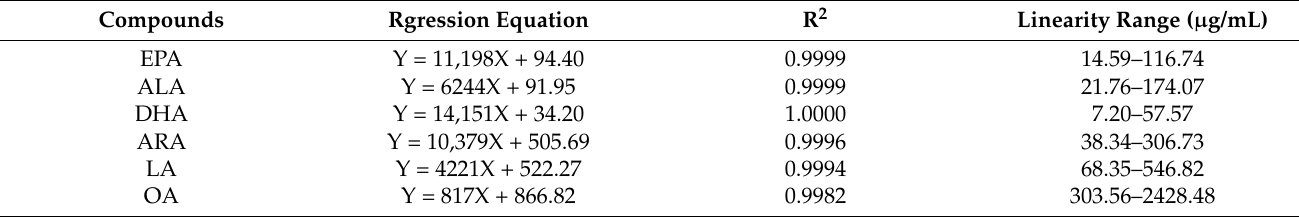
Table 4. Regression Equations of six PUFAs